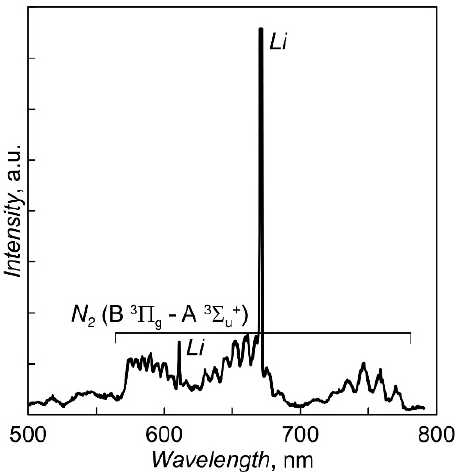
Figure 2. The fragment of optical emission spectrum of discharge plasma under Li 3 PO 4 evapora-